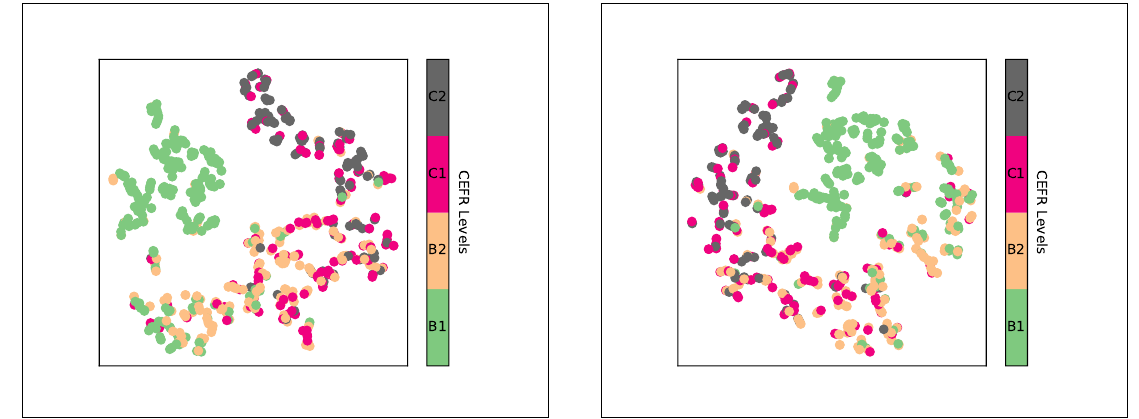
Figure 5. 2D visualizations of the dataset obtained with two executions of